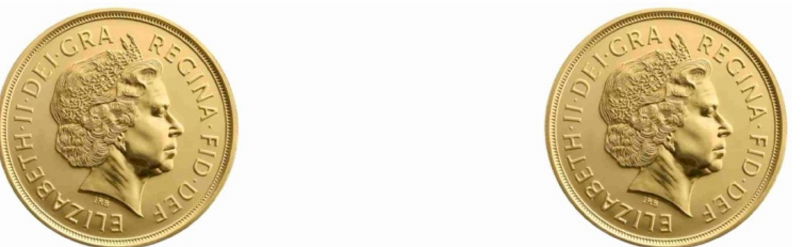
Figure 9. Arrange two coins so their centres are the interpupillary distance apart (approximately 6 cm). Cross fuse the two coins so the right eye looks at the left coin and the left eye looks at the right coin. The central fused coin appears to shrink in size. This is vergence